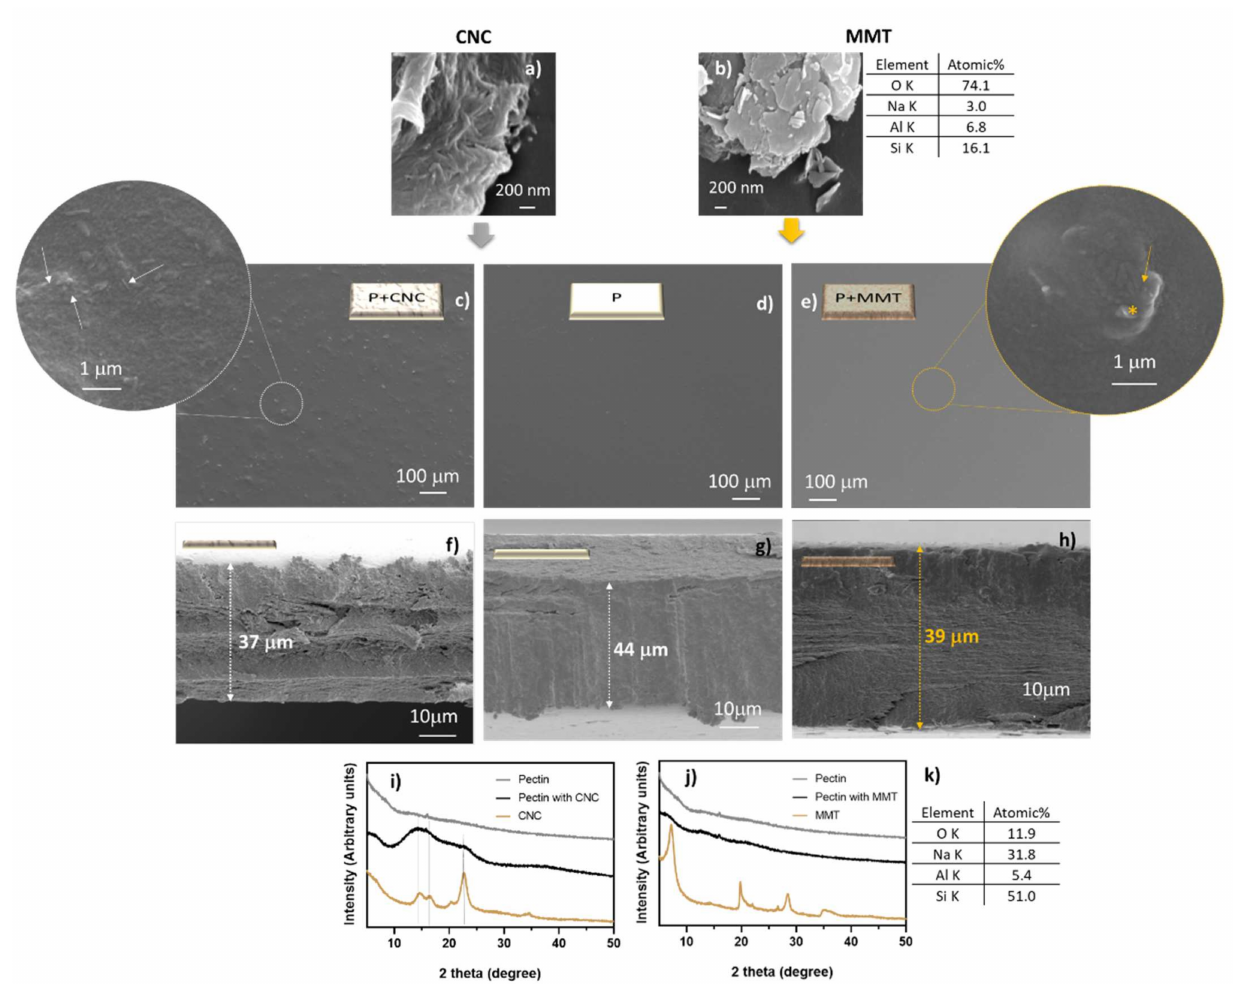
Figure 3. Physicochemical characterization of the bionanocomposites. Scanning electron microscopy (SEM) images of the CNC ( a ) and MMT ( b ) NPs with the corresponding chemical elemental com- position presented for the MMT NPs; SEM top-view images of pectin films ( d ), pectin loaded with CNC ( c ), or loaded with MMT ( e ) and respective SEM cross-section images ( f - h ), with the corre- sponding thicknesses; X-ray diffraction (XRD) diffractograms ( i , j ) of the bionanocomposites and chemical elemental composition of the pectin film loaded with MMT determined by energy disper- sive X-ray spectroscopy (EDX) ( k ). * Inset in magnified Figure 3e correspond to the NPs loaded in the